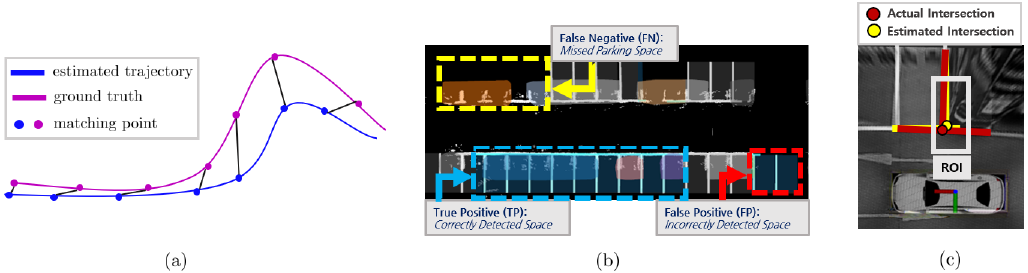
Figure 12. Details of performance measuring criteria for SLAM trajectory evaluation and parking space detection. ( a ) Process of evaluating absolute trajectory error (ATE). ( b ) Meanings of true positive (TP), false negative (FN) and false positive (FP) in our experiment. ( c ) Actual intersection and estimated intersection for measuring accuracy of parking